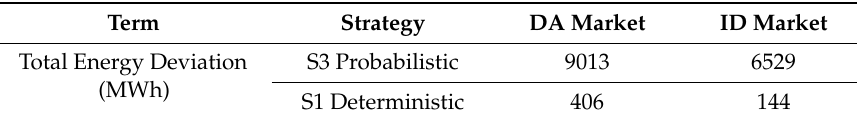
Table 8. Total energy deviation.